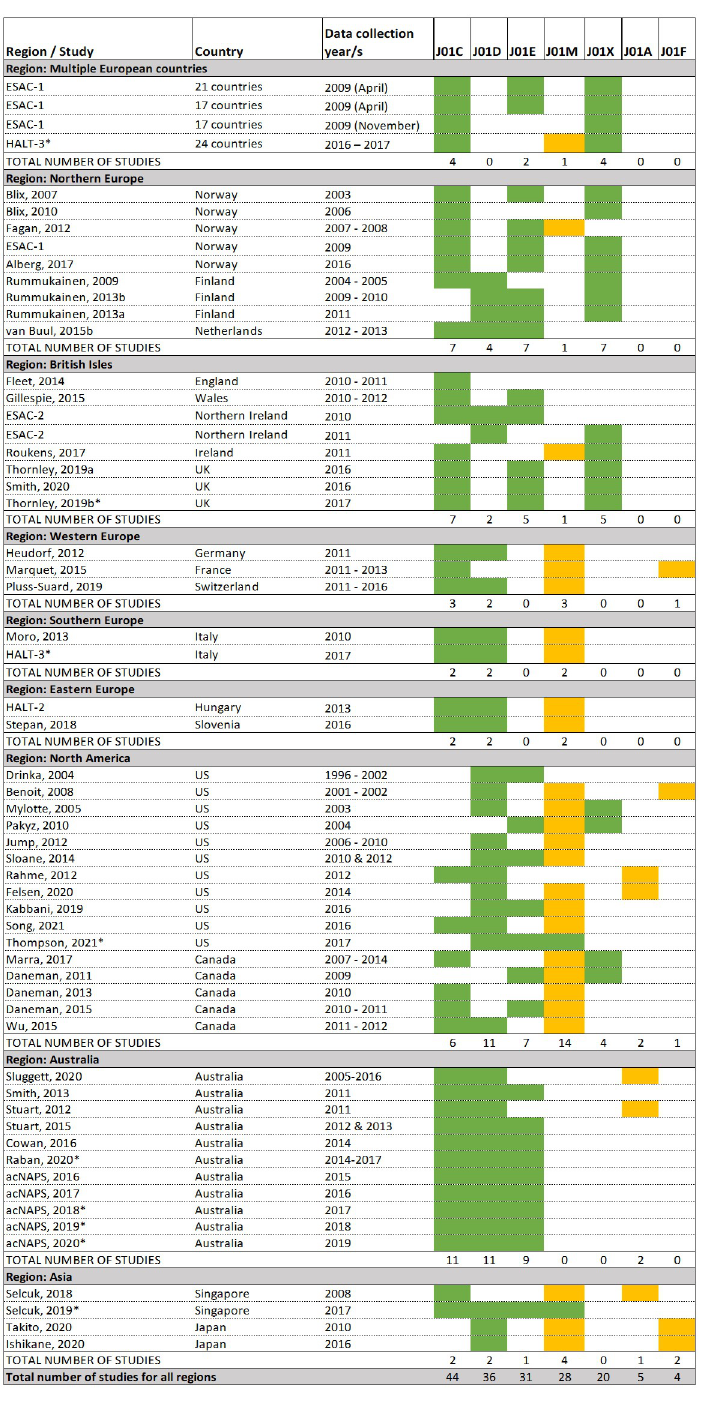
Fig 4. Classes of three most frequently used antibiotics reported by studies. J01C is penicillins; J01D is cephalosporins; J01M is quinolones; J01X is other classes (includes only methenamine and nitrofurantoin); J01A is tetracyclines; J01F is macrolides. Classes J01M, J01A and J01F are on the World Health Organization’s (WHO) AWaRe ‘Watch List’ and should be targeted for reduced use due to high resistance potential. Studies including data from 2017 or later are indicated with an asterisk. The WHO AWaRe list was first published in 2017.